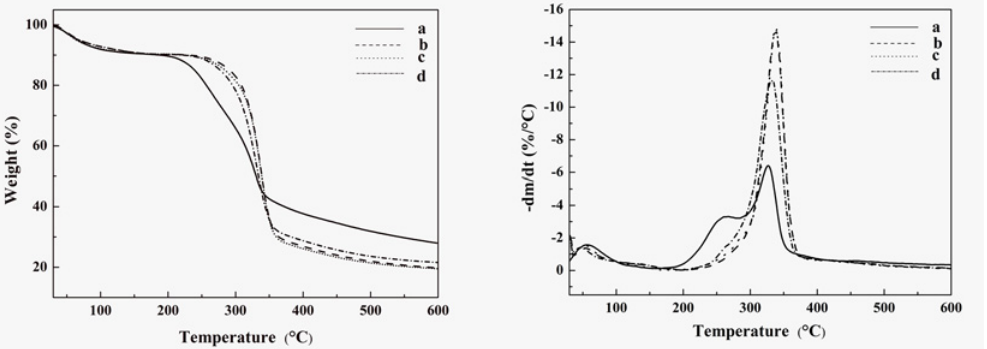
Fig 5. TG and DTG curves of (a) untreated, (b) CNF-1, (c) CNF-2, and (d)CNF-3.